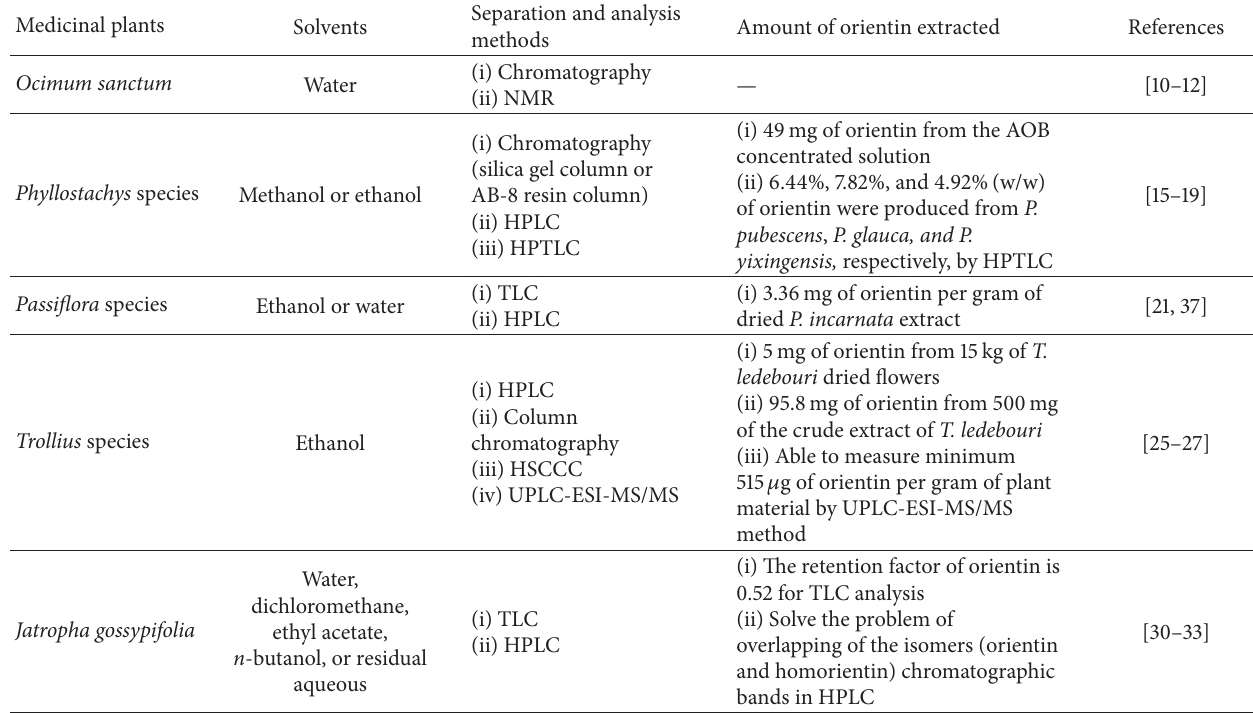
Table 1: Isolation of orientin from different medicinal